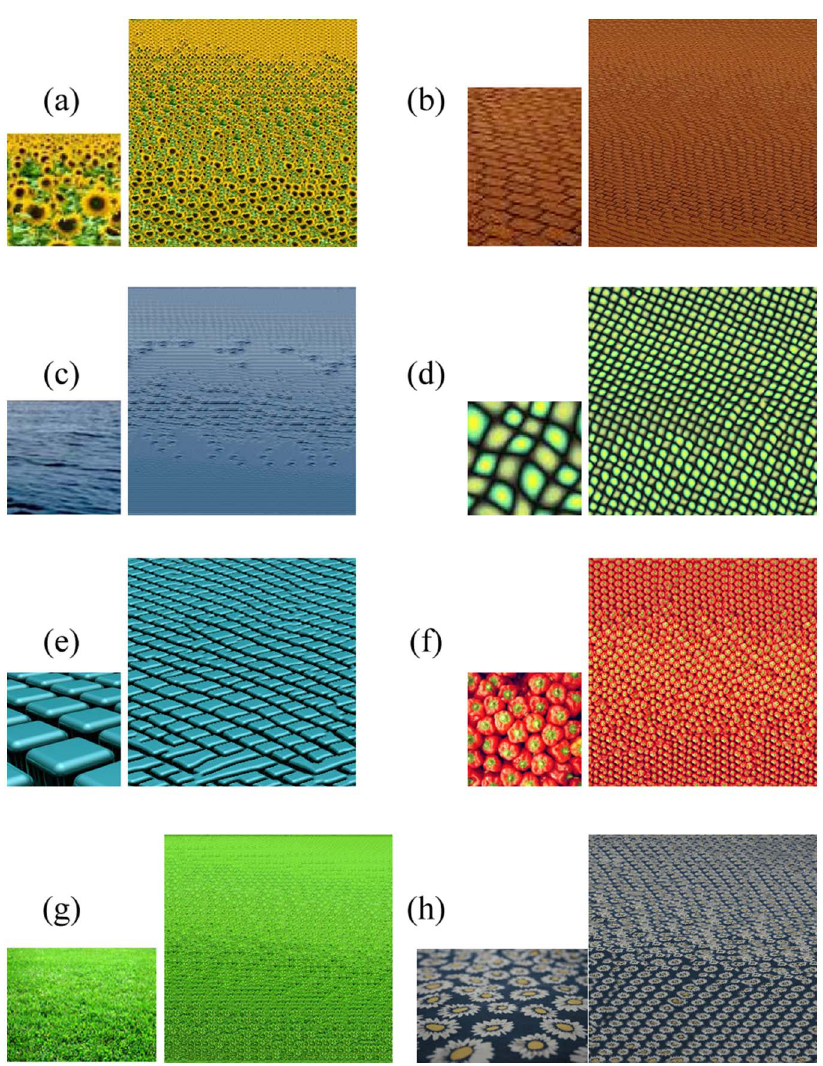
Figure 10. Perspective texture synthesis of few selected sample textures, for all the textures input is on the left and output is to the right. Second and third row’s last input textures are taken from [Kwatra et al. 2005].